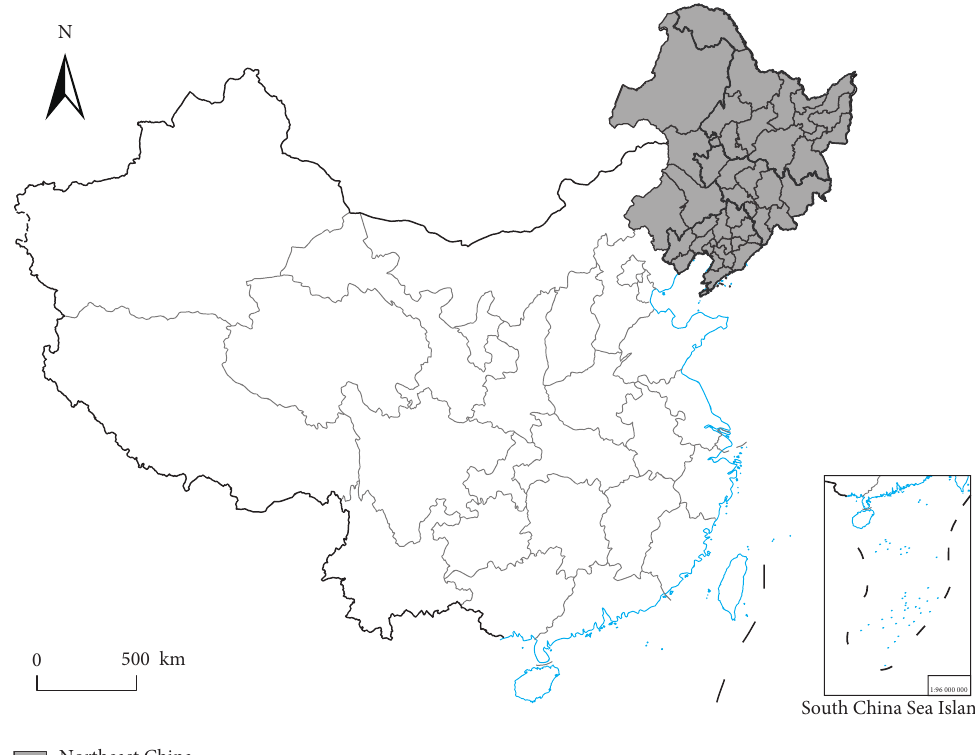
Figure 1: The location of Northeast in